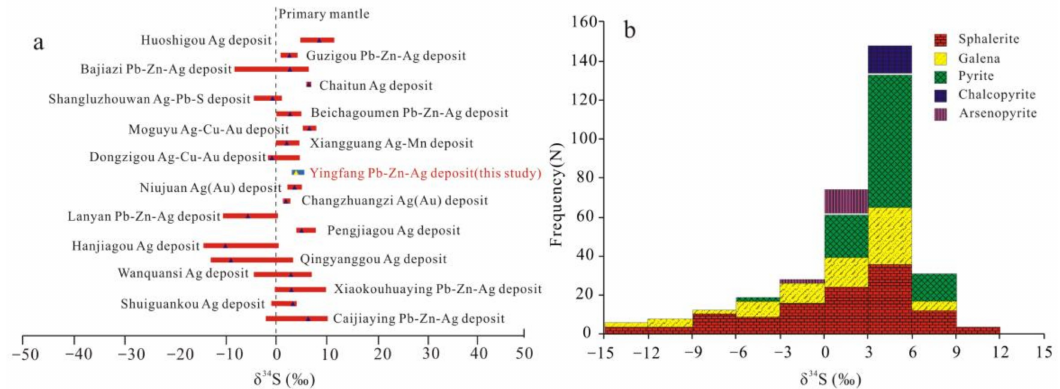
Figure 9. Sulfur isotopic composition. ( a ) (Refer to Table 3 for data) and histogram; ( b ) Sulfur isotopic composition of sulfides from the silver polymetallic deposits on the